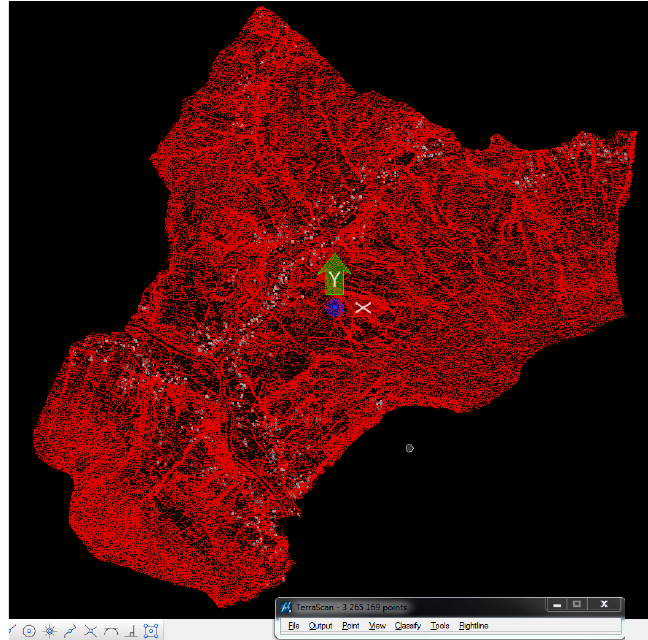
Figure 12. The Model keypoints for the entire area .